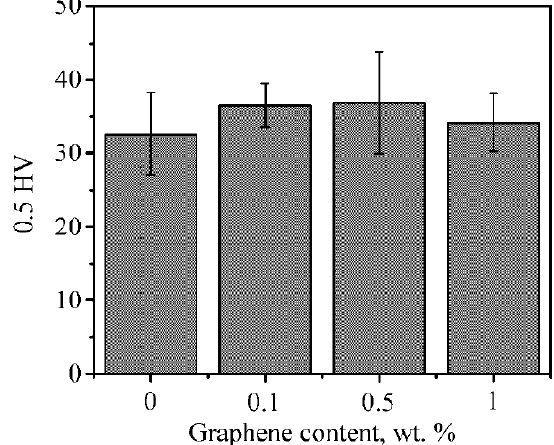
Fig. 6. The effect of TEG contents in the initial pow- der mixture on composite microhardness.